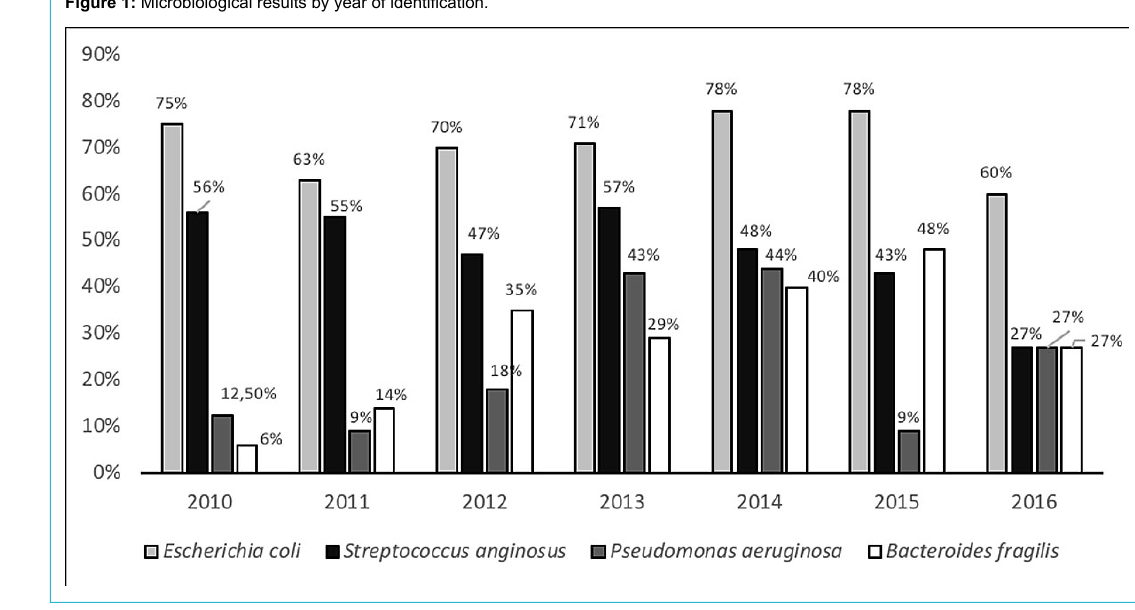
Figure 1: Microbiological results by year of identification